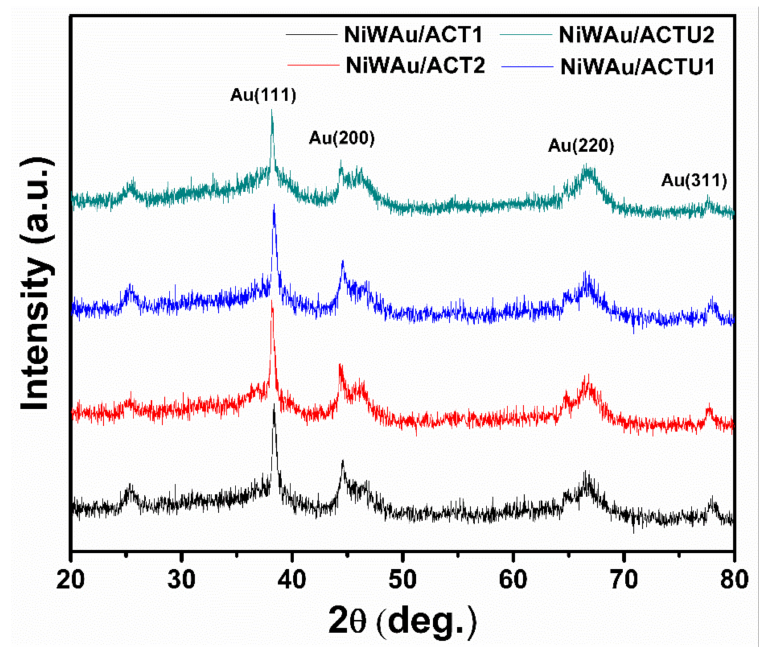
Figure 5. XRD patterns of NiWAu/ACT and NiWAu/ACTU